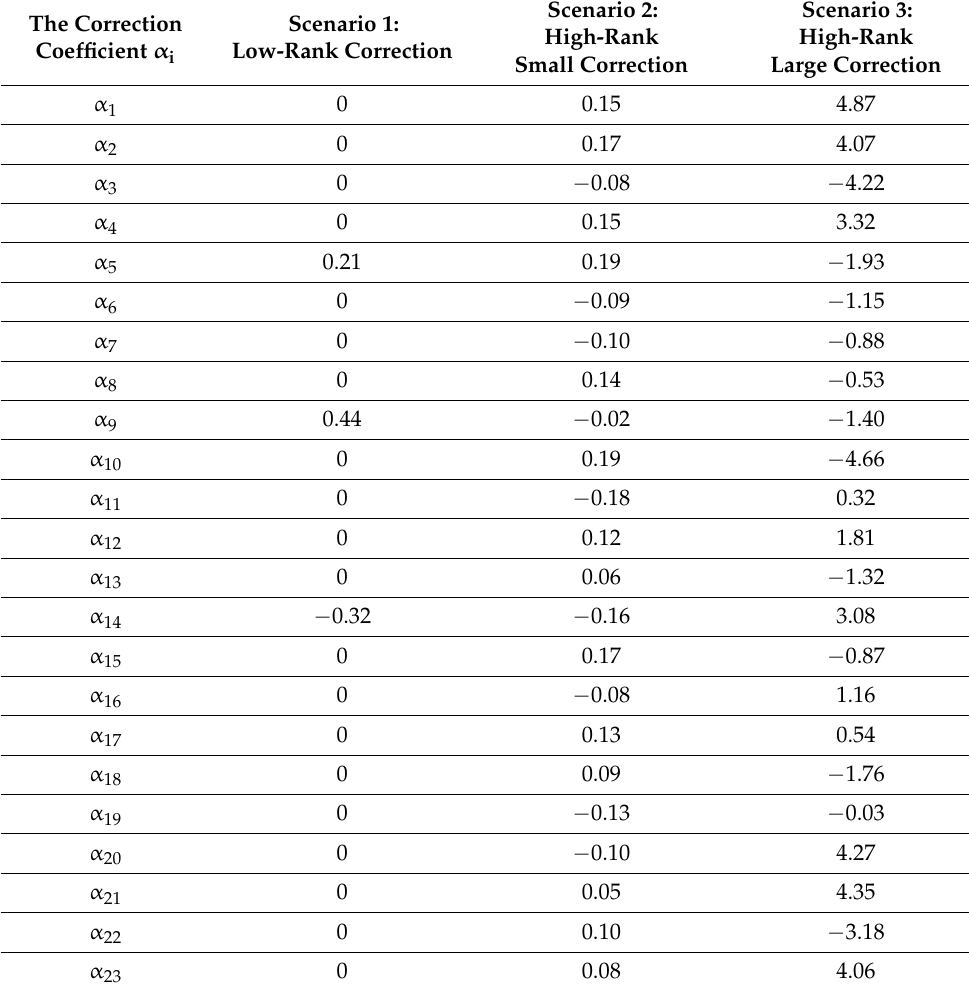
Table 1. Different correction cases of a 23-bar